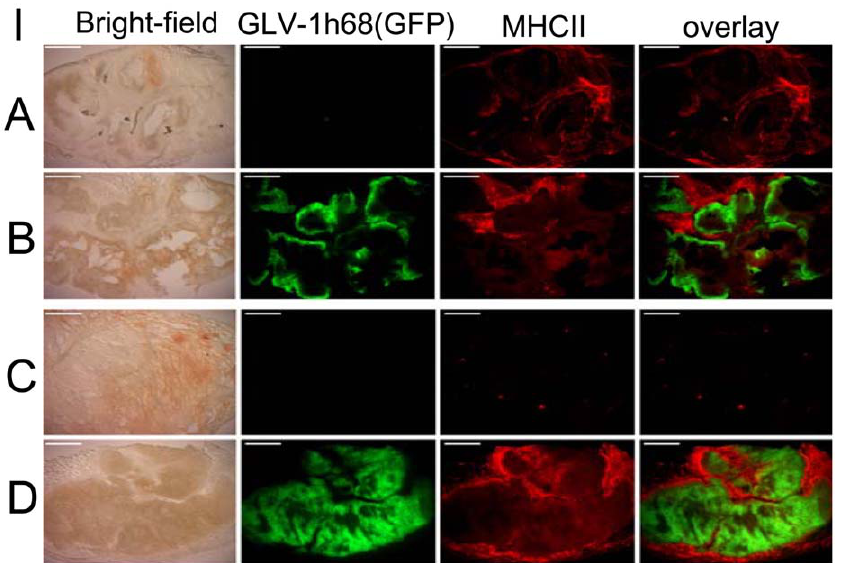
Figure 6. Immunohistochemical staining of MHC class II-positive cells in GLV-1h68-infected and uninfected HuH7 or PLC xenograft tumors at 10 dpi. Mice bearing tumors of HuH7 (A, B) or PLC (C, D) origin either were mock treated (A, C) or infected with GLV-1h68 (B, D). Tumor sections were labeled with an anti-MHCII antibody (red) and viral infection was indicated by GFP fluorescence (green). In addition, overlays of MHCII and GFP signals and transmission images (bright-field) are shown. Scale bars represent 1 mm.